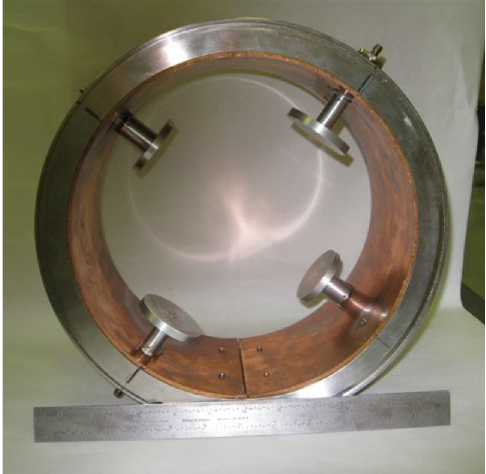
FIG. 20. Damper ring with four mushroom capacitive probes each with a 51 mm diameter disk on a 25 mm-long stem. A 1 ft ruler is added for scale.